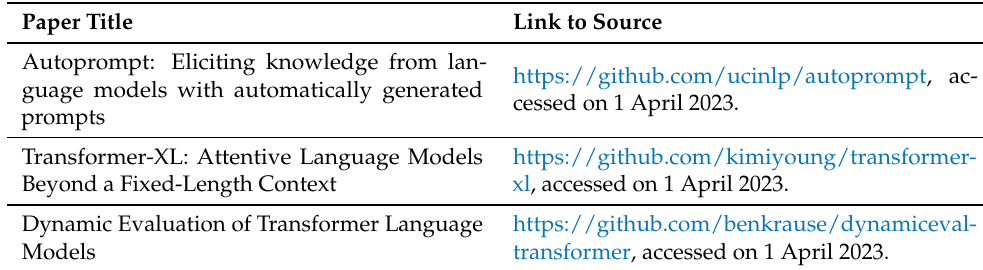
Table 1. Source code links for Language